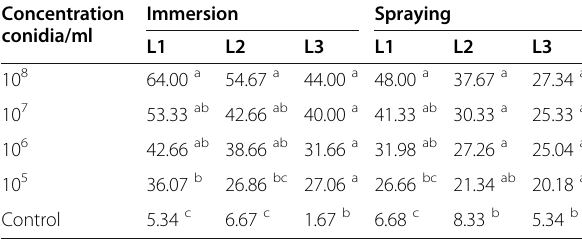
L1 the 1st instar larvae, L2 the 2nd instar larvae, L3 the 3rd instar larvae. The same letters in each column had no statistically significant differences.